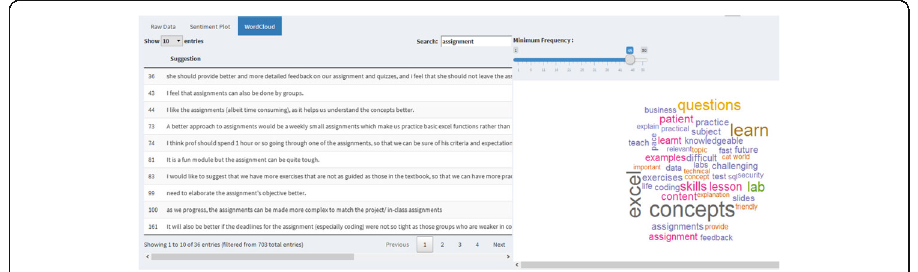
compare across different